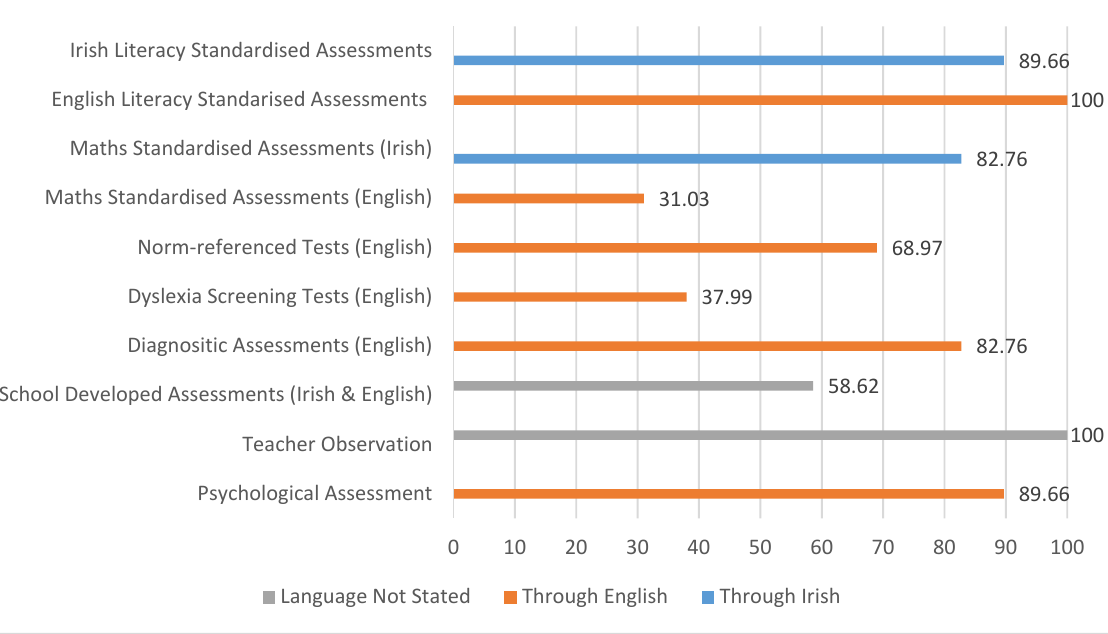
Figure 2. The assessment methods used by schools in the present study, for the selection of students for additional support.